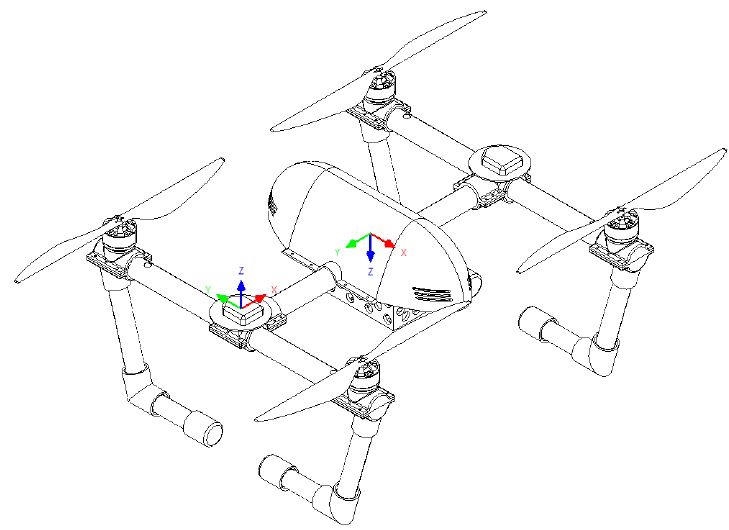
Figure 1. Unmanned Aerial Vehicle (UAV) concept with mounted Global Positioning System (GPS) antennas and important coordinate frames.